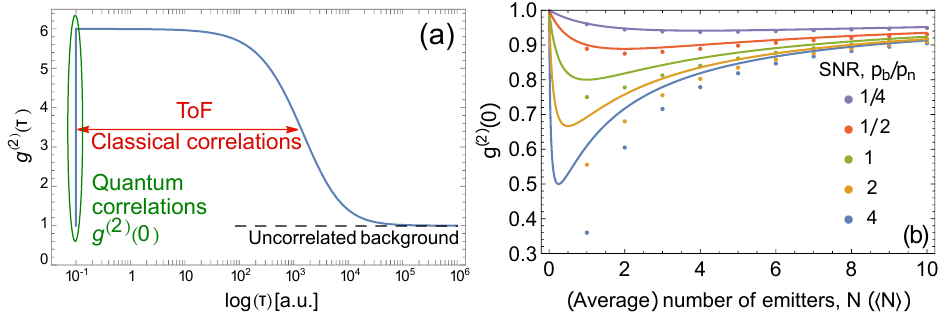
Figure 1. ( a ) Typical dependence of g ( 2 ) on the correlation delay time, τ . The dip at τ = 0 is due to non-classical correlations. The shoulder is due to intensity correlations that can be classical. These correlations occur for 0 < τ << t ToF , where t ToF is the time of flight. At longer τ , the uncorrelated background emerges. ( b ) g ( 2 ) ( 0 ) vs. (average) number of emitters in the interrogation volume. The different colors correspond to different values of SNR, p b / p n . The circles correspond to the static case common to static fluorescense measurements, where g ( 2 ) ( 0 ) is plotted against the exact number of emitters N , Equation (4). The solid lines correspond to the dynamic case common to flow cytometry measurements, where g ( 2 ) ( 0 ) is plotted against the average number of emitters (cid:104) N (cid:105) , Equation (5). The same horizontal axis is used for both N and (cid:104) N (cid:105) .